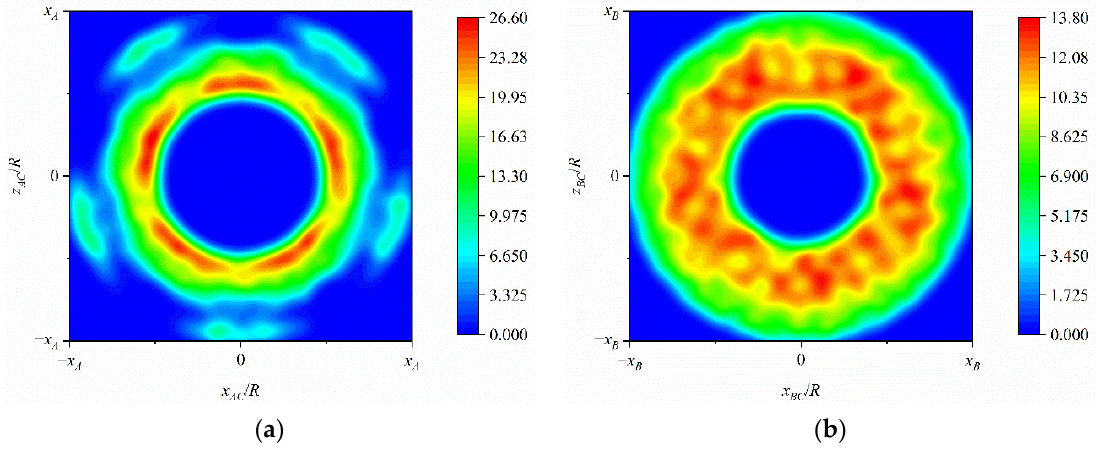
Figure 12. Energy distribution after modularization: ( a ) the first segment (curve AC ); ( b ) the second segment (curve CB ). Table 3. Detailed values of energy collection and distribution.